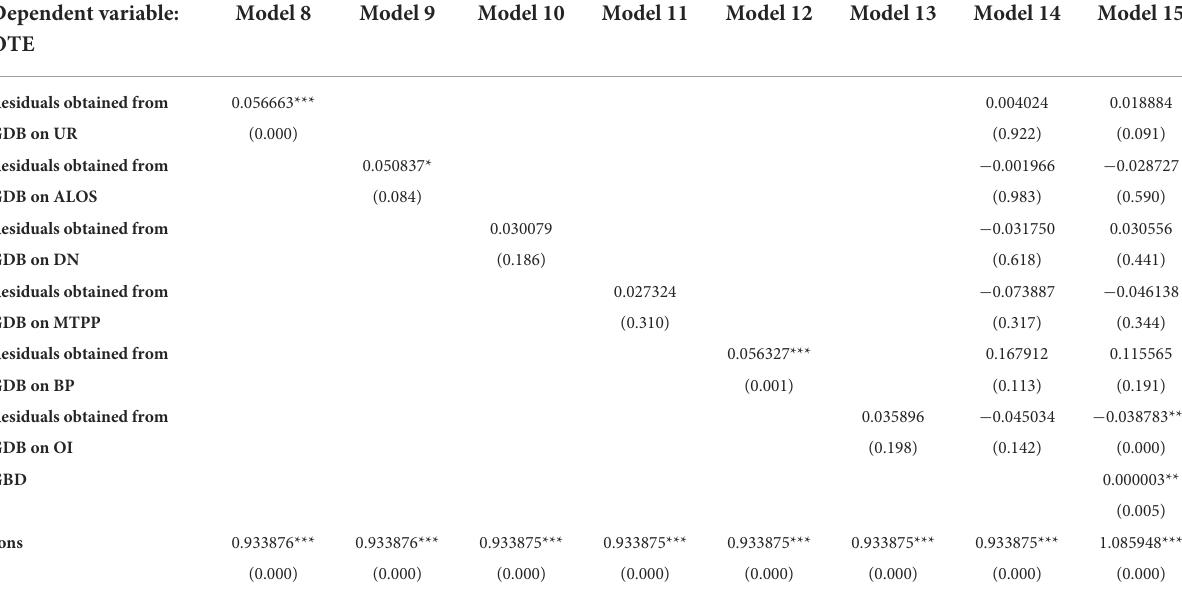
TABLE 7 Results of bootstrapping truncated regression for tertiary hospitals: estimations of the residuals from